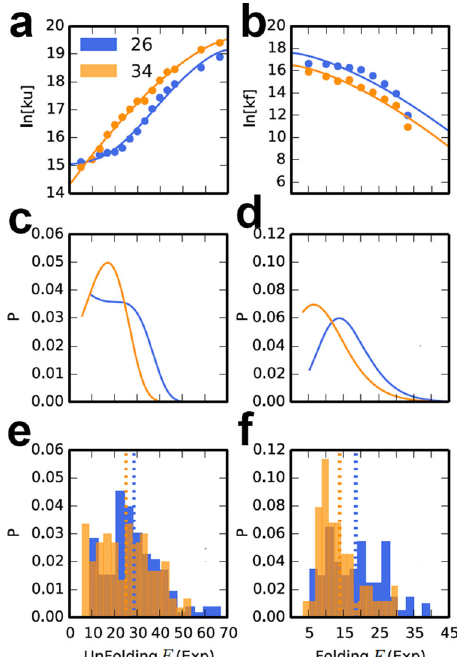
Fig. 4 Simulated unfolding and refolding rates and force distributions of ADR1a. Simulated force-dependent rates of ADR1a a unfolding and b folding on the ribosome. Data for L = 26 (ADR1a inside tunnel) and L = 34 (ADR1a in mouth of tunnel) are shown in blue and orange, respectively. computed using the force-dependent rates from simulation together with a time-dependent applied force. Corresponding experimental force distributions for unfolding and folding are shown in e and f ,